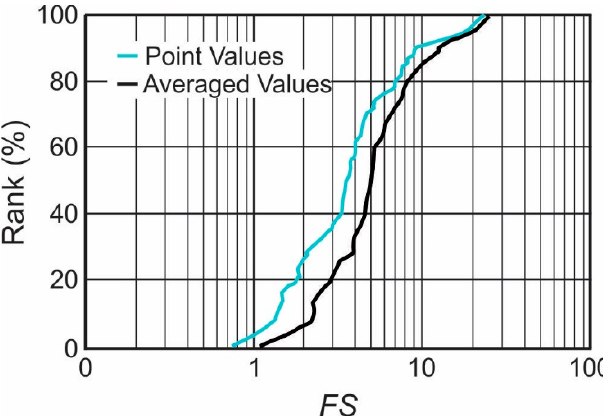
Figure 6. Percentile plot of total stress FS for all cores using the deterministic approach.